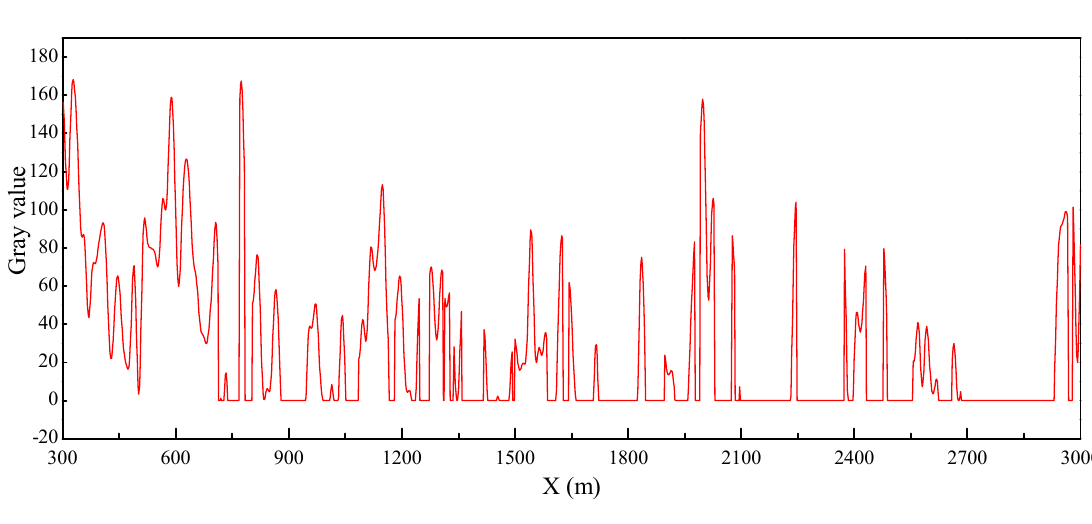
Figure 4. Spatial distributions of water elevation and image gray value along the radius. The coordinates of this radius are Y = 0 m and 300 m < X < 3000 m.